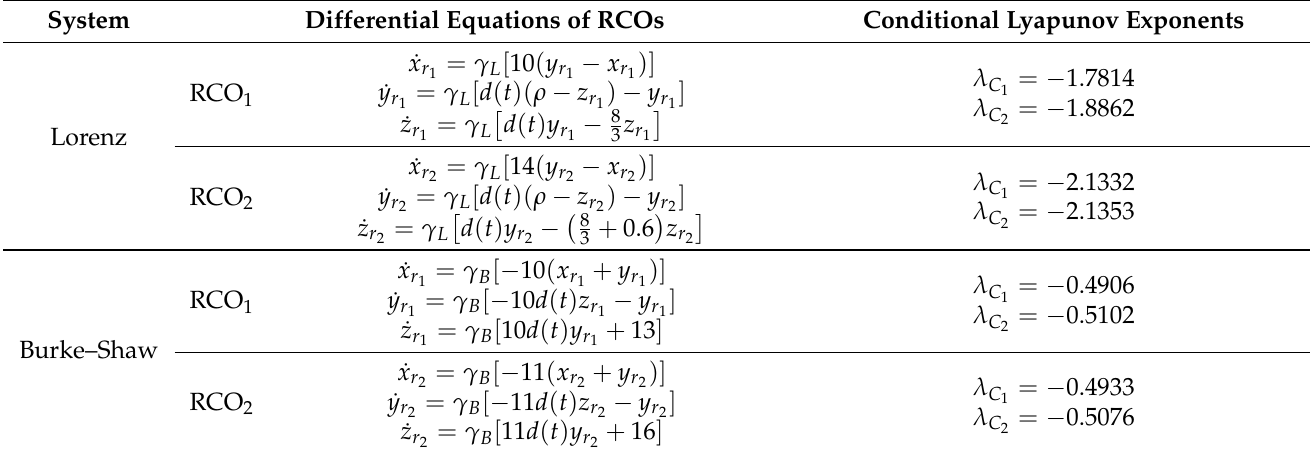
Table 2. Dynamical equations for the response oscillator and its corresponding conditional-Lyapunov exponents demon- strating the stability of the response chaotic